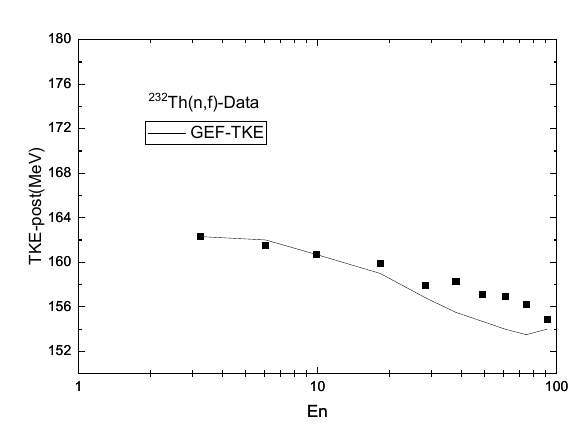
Figure 7. A comparison between the measured values of the TKE and those predicted by the GEF model for the fast neutron induced fission of 232 Th.